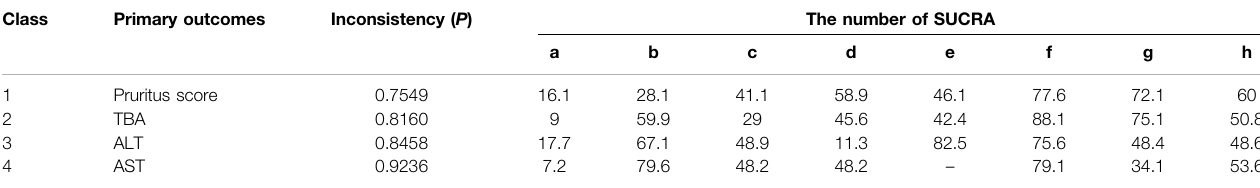
TABLE 4 | The inconsistency of model and number of SUCRA. Class